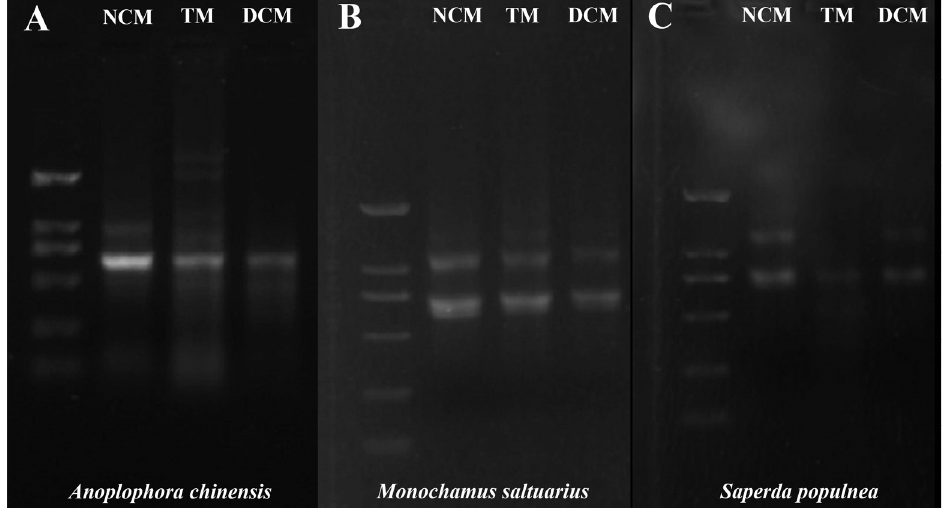
Figure 5. Gel electrophoresis images for haemolymph RNA obtained by three collection methods in adults of three cerambycid beetle species. ( A ): Gel electrophoresis images for haemolymph RNA obtained by three collection methods of Anoplophora chinensis. ( B ): Gel electrophoresis images for haemolymph RNA obtained by three collection methods of Monochamus saltuarius. ( C ): Gel electrophoresis images for haemolymph RNA obtained by three collection methods of Saperda populnea.